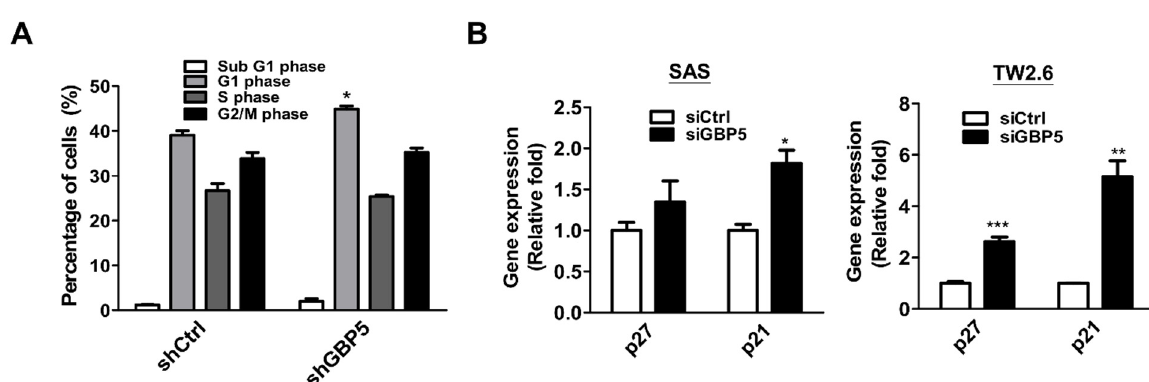
Figure 3. Effects of GBP5 in cell cycle progression of OSCC cells. ( A ) The stable GBP5-silenced TW1.5 cells harboring scrambled shRNA (shCtrl) or shRNA against GBP5 (shGBP5) were seeded for 24 h and harvested for cell cycle distributions by flow cytometry. All fixed cells were stained with propidium iodide to examine the proportions of different cell cycle phases using flow cytometry. FlowJo software was used to analyze the flow cytometry data. ( B ) Gene expression levels of p21 and p27 in GBP5-silenced SAS and TW2.6 cells. All cells were transfected with 10 nM scramble siRNA (siCtrl) and GBP5 siRNA (siGBP5) for 72 h. All quantitative results are calculated as the mean ± SEM from three independent experiments. A value of p < 0.05 was considered significant (*** p < 0.001, ** p < 0.01, * p < 0.05).